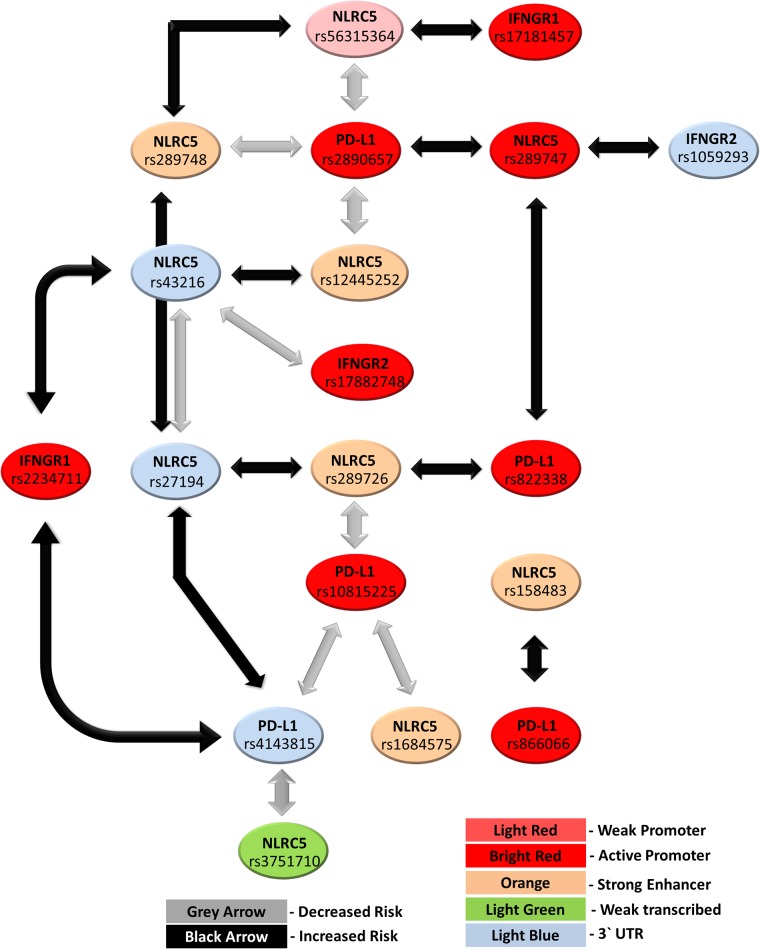
NLRC5-PD-L1-IFNGR1/2 pair-wise interactions. The color indicates the SNPs’ location displayed by UCSC Genome Browser on lymphoblastoid cell lines (GM12878).